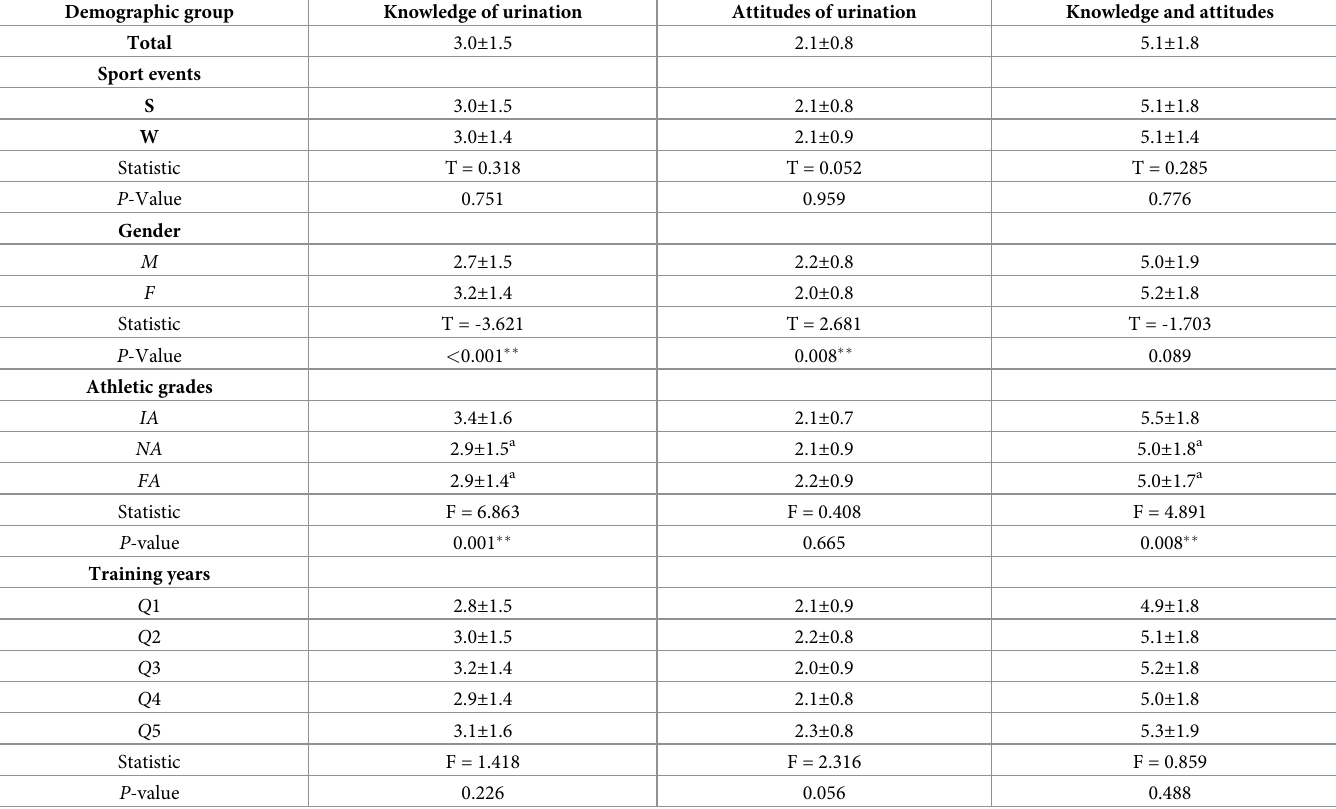
Table 3. Mean scores of knowledge and attitudes of urination (Mean ±